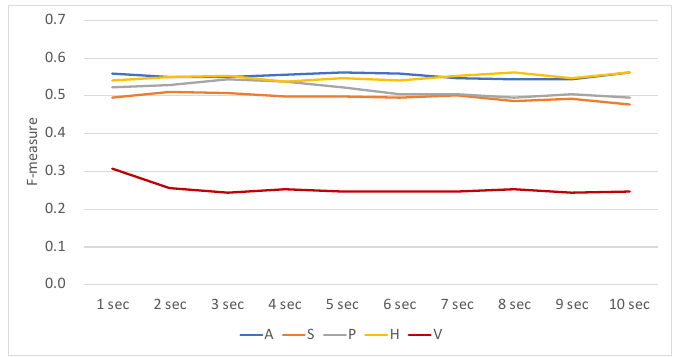
Figure 4. F-measure values (shown as the vertical axis) of each feature set in listening model according to window size from 1 to 10 s.